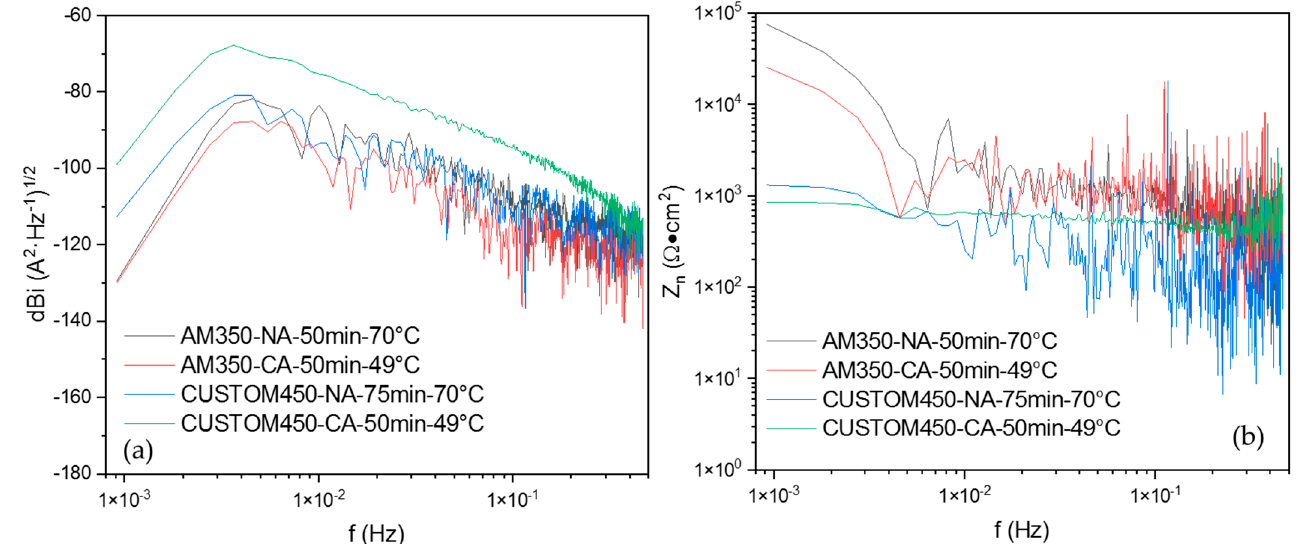
Figure 3. ( a ) Power spectral density (PSD) and ( b ) Noise impedance (Z n ) for CUSTOM450 and AM 350 passivated stainless steels immersed in 5 wt. % NaCl solution. Table 5. Parameters obtained by PSD.